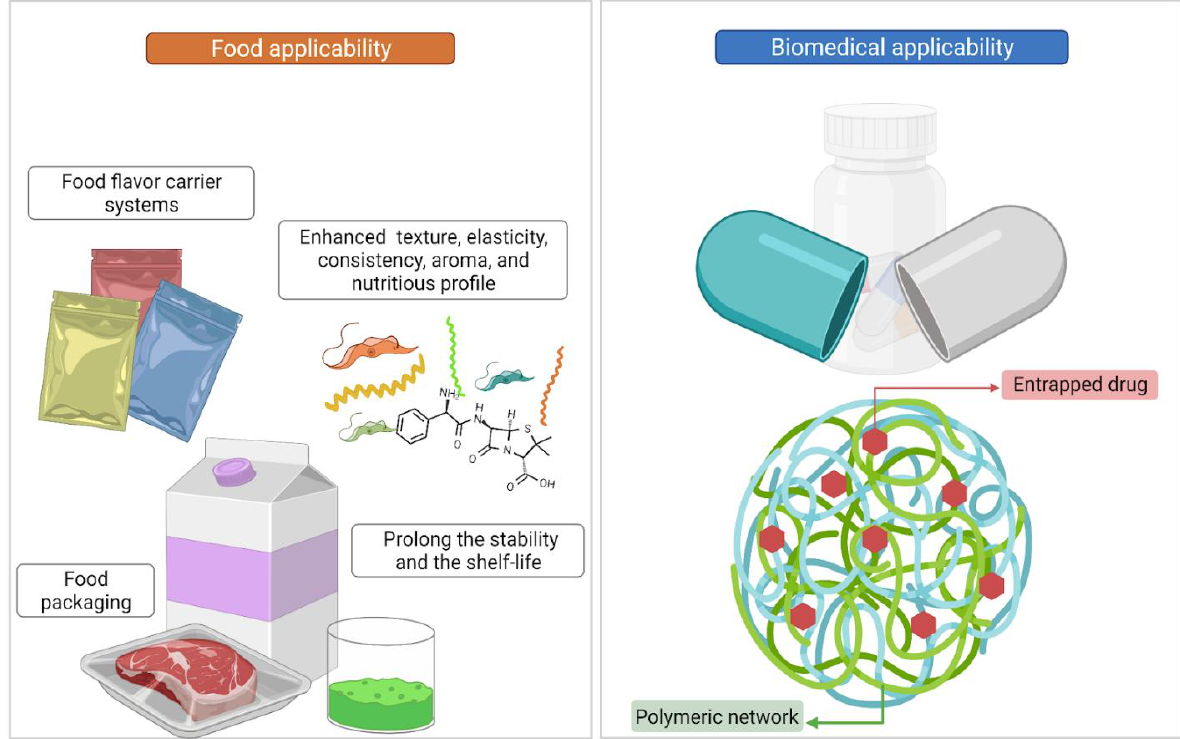
Figure 4. PEG applications in the food and biomedical sector (image created using the BioRender application; https://app.biorender.com).